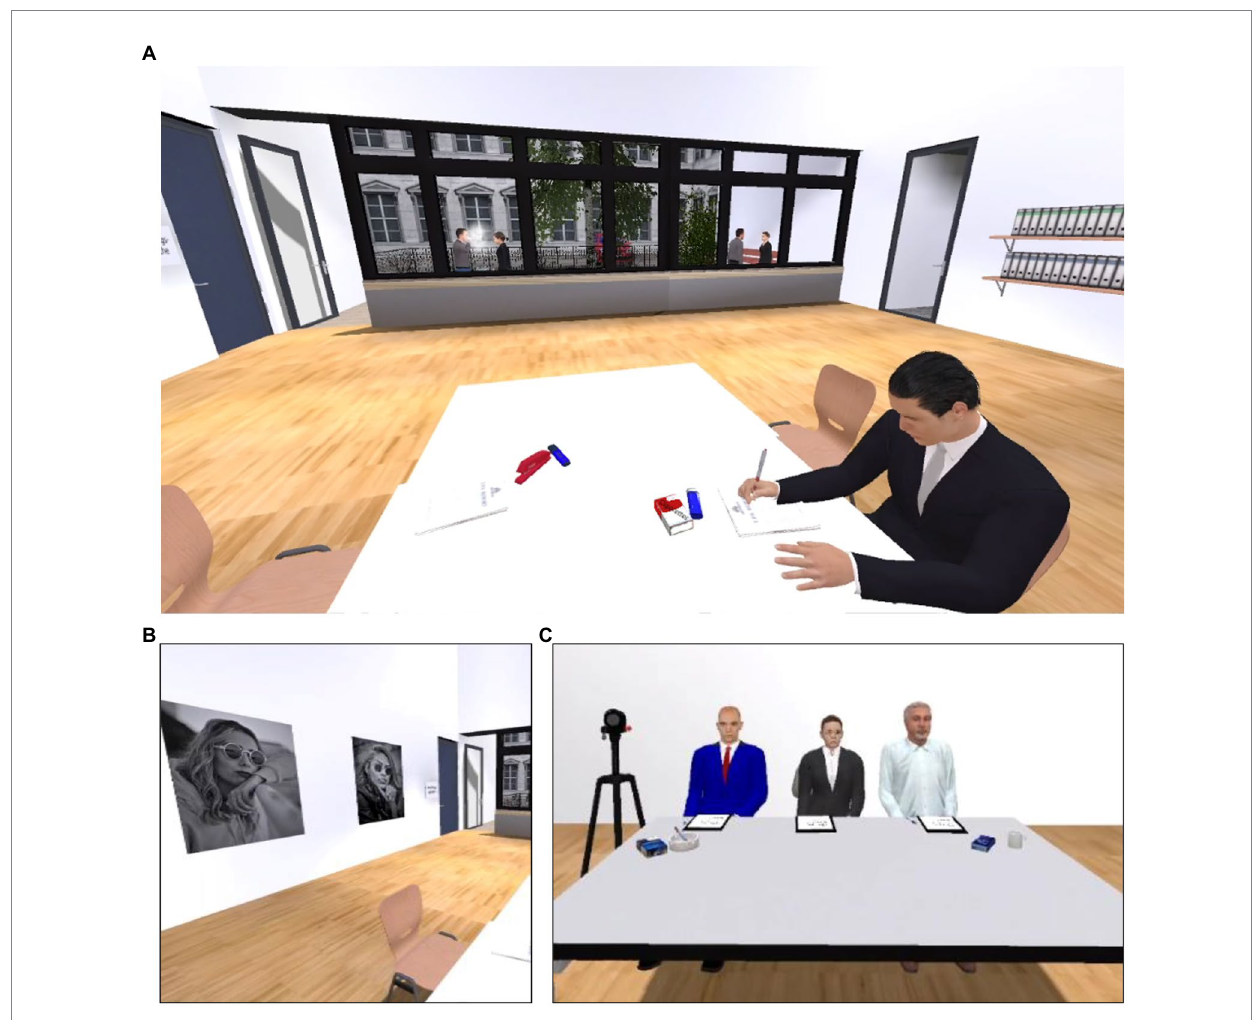
FIGURE 1 Virtual environment of VR-TSST. (A) Preparation room. (B) Pictures in the preparation room. (C) Job interview committee. Image modified to omit